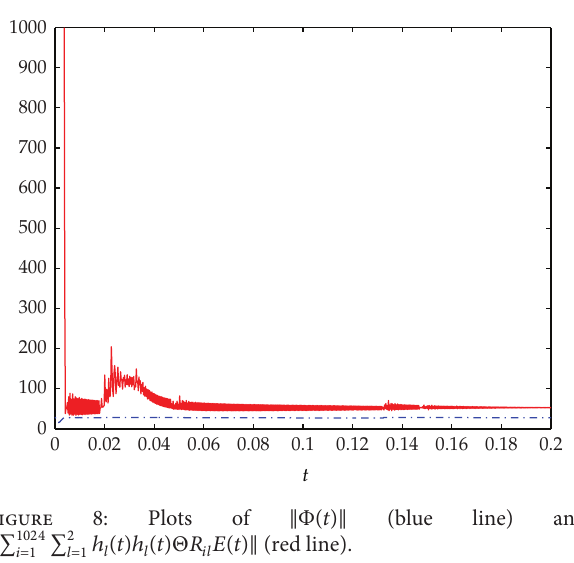
Figure 8: Plots of ‖Φ(𝑡)‖ (blue line) and ℎ (𝑡)ℎ (𝑡)Θ𝑅 𝐸(𝑡)‖ (red ‖∑ 1024 ∑ 2 𝑙 𝑙 𝑖𝑙 𝑖=1 𝑙=1